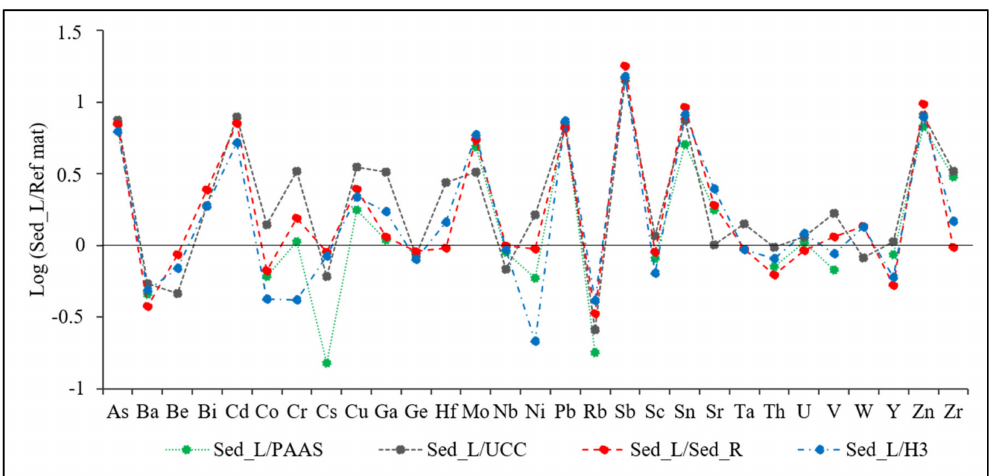
Figure 7. Normalization of average annual TE concentrations in the Lom é lagoon sediments (Sed_L) using di ff erent reference materials (PAAS, UCC, Sed_R, and